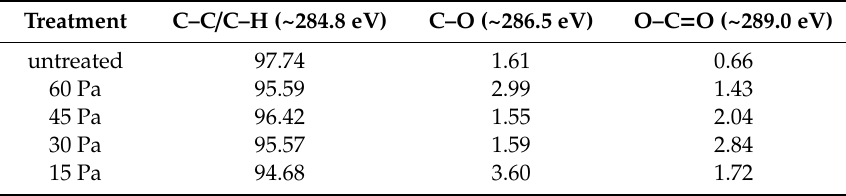
Table 1. Relative concentration of C 1s sub-peaks [%] after peak fitting.